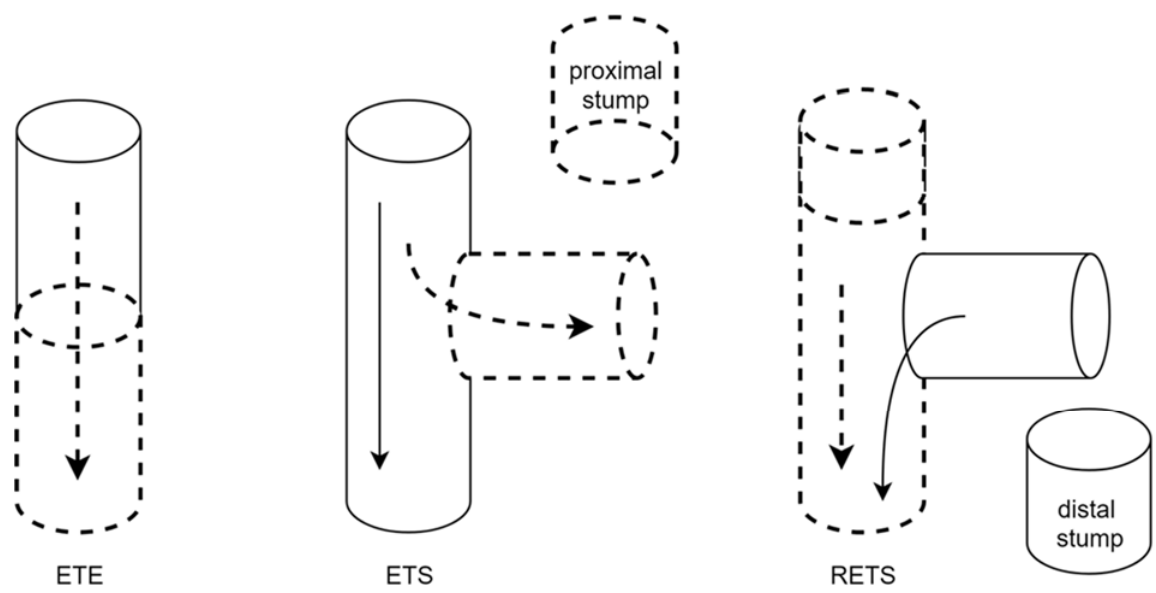
Figure 10. Illustration of the types of nerve transfer (adapted from Lee et Wolfe 2012 [31]). Full line: donor nerve. Dash line: receiving nerve. ETE: end-to-end suture. ETS: end-to-side suture. The axons sprout from the side of the donor nerve into the end of the recipient nerve. RETS: reverse end-to-side suture. The donor axons enter the receiving nerve from its side in order to enhance the axonal sprouting process of the repaired receiving nerve.